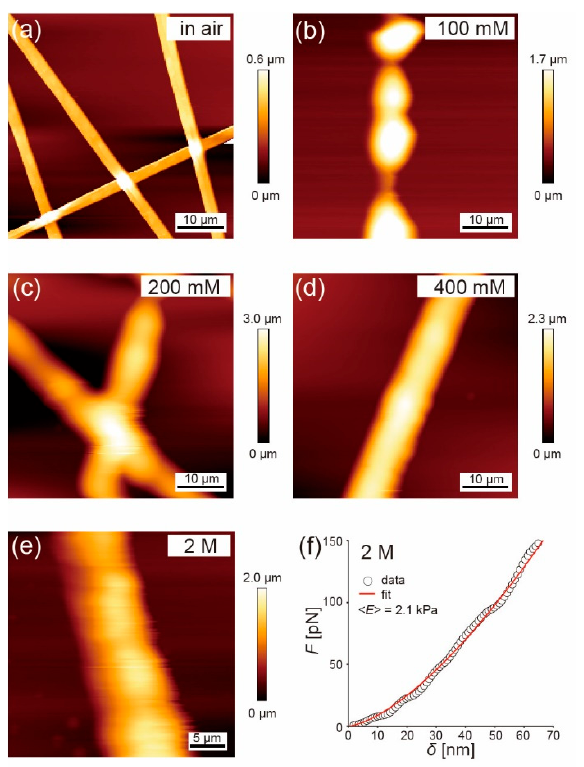
Figure 6. AFM topographic profiles of β CD-gelatin/Ad-gelatin fibers ( a ) before chemical crosslink- ing (in air) and after crosslinking with ( b ) [ EDC ] = [ NHS ] = 100 mM, ( c ) 200 mM, ( d ) 400 mM, and ( e ) 2 M (in PBS). ( f ) Force–distance curves of a β CD-gelatin/Ad-gelatin fiber crosslinked in [ EDC ] = [ NHS ] = 2 M.